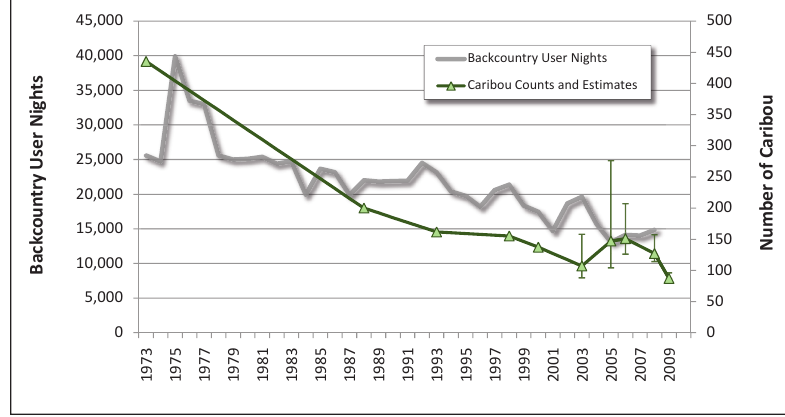
2009.Fig. 5. Number of caribou and number of backcountry user nights in Jasper National Park from 1973-2009.